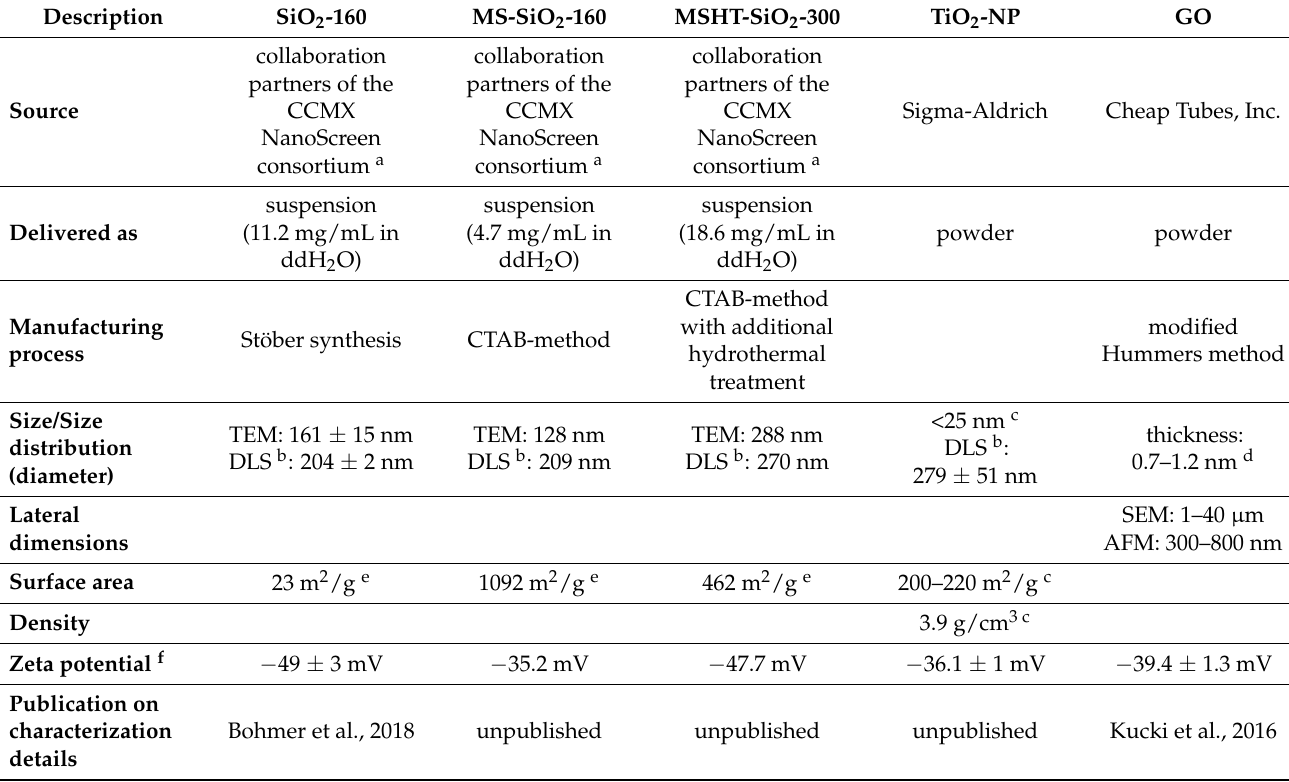
Table 3. Characteristics of cytotoxic